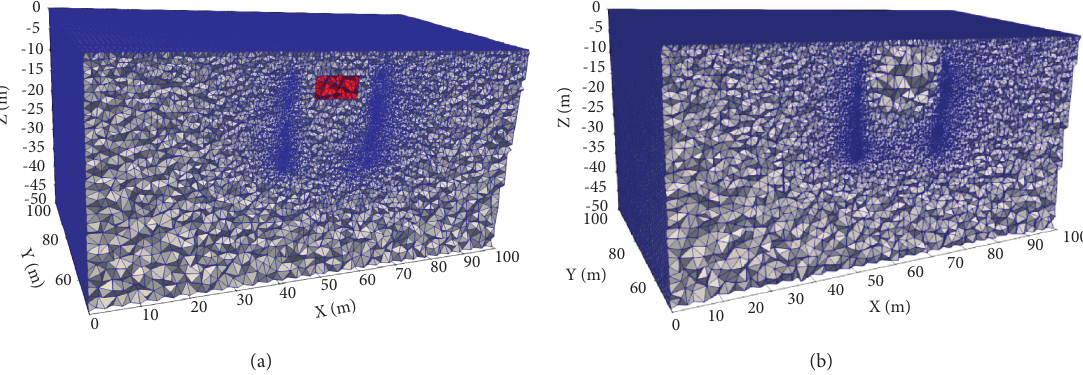
Figure 6: Forward and inversion grid of the buried rectangular model under the flat surface. (a) Forward mesh and (b) inversion mesh.